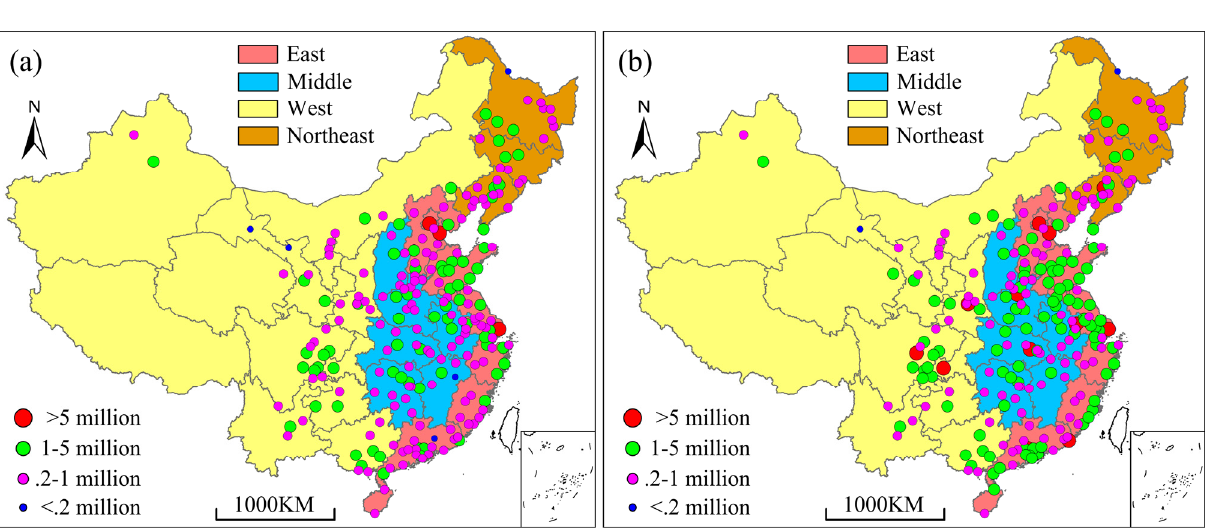
Figure 1. Spatial distribution of China’s prefectural-level cities and municipalities grouped by the population sizes in 1994 ( a ) and 2011 ( b